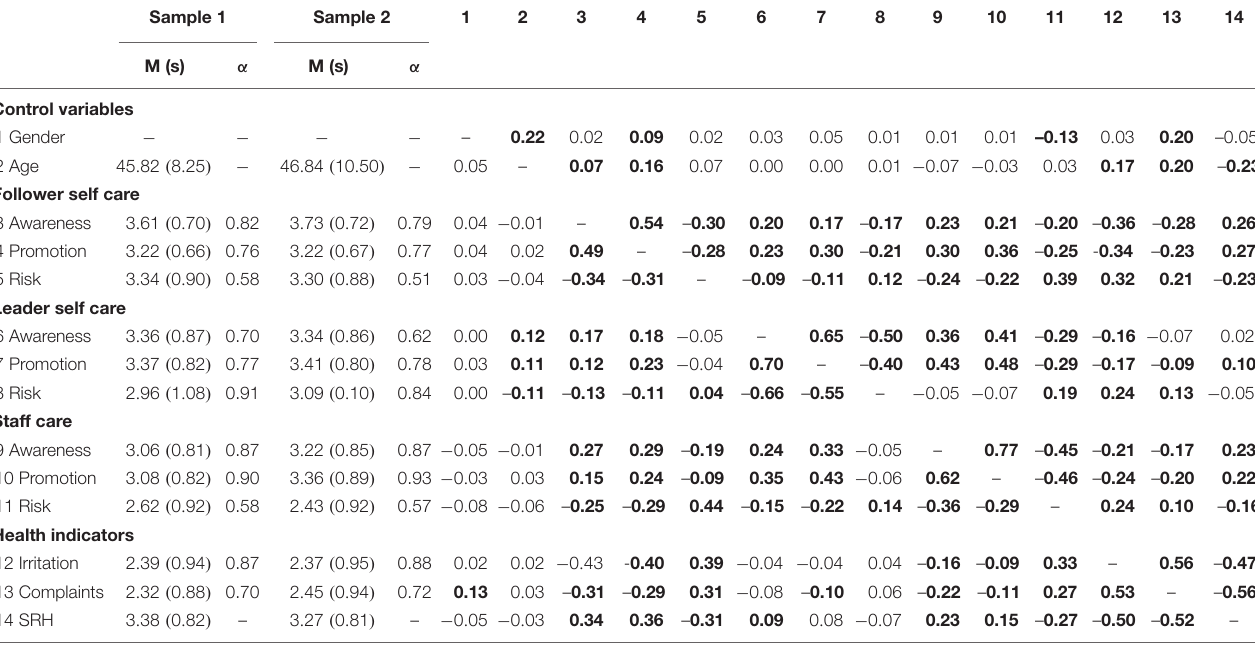
TABLE 1 | Descriptive statistics and zero-order correlations of all study variables. Correlations for sample 1 are below the diagonal, correlations for sample 2 above. Sample